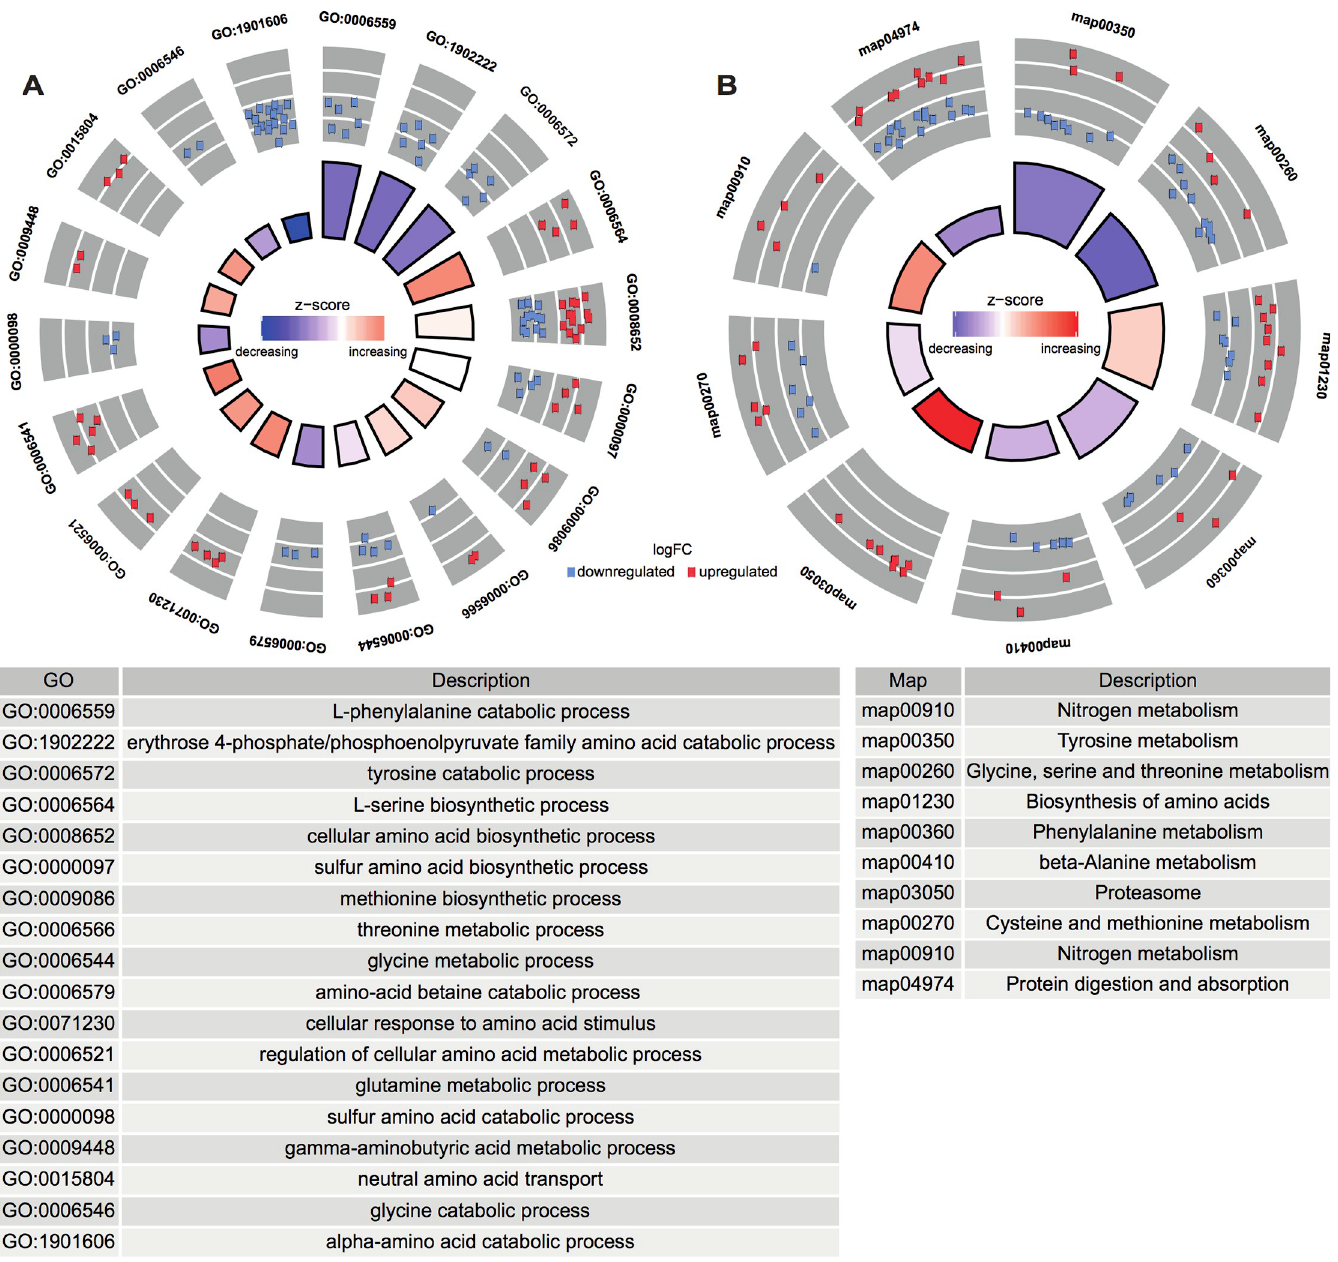
Fig 3. Amino acid metabolism biological processes (A) and pathways (B) enriched with DEGs identified in meta-analysis. For the two Circos plots, the height of each bar in the inner circle indicates statistical significance of the enriched GO terms (A) and KEGG pathways (B), while color of the bars represents the overall regulation effect of each process. The outer circle shows the differential expression of genes associated with each process, where red and blue represent upregulation and downregulation in symbiotic anemones, respectively. The table describes the annotation of each term or